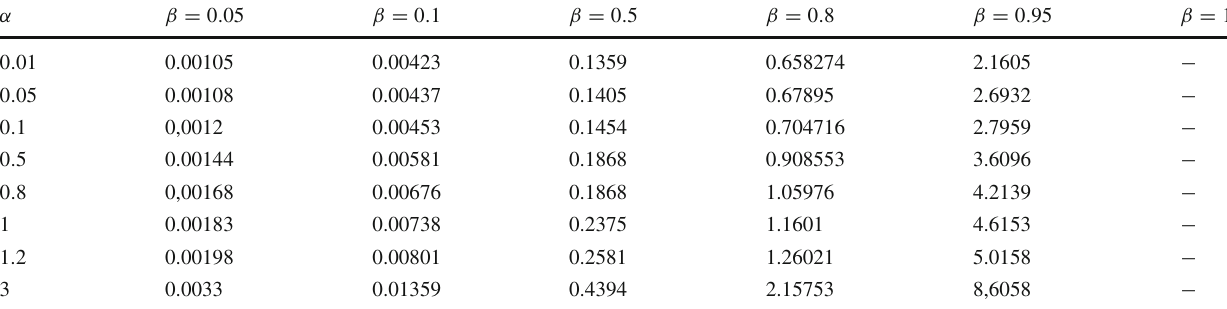
Table 1 Numerical values for (cid:15) r = r max − r min for the different values of the magnetic coupling parameter β and the parameter α